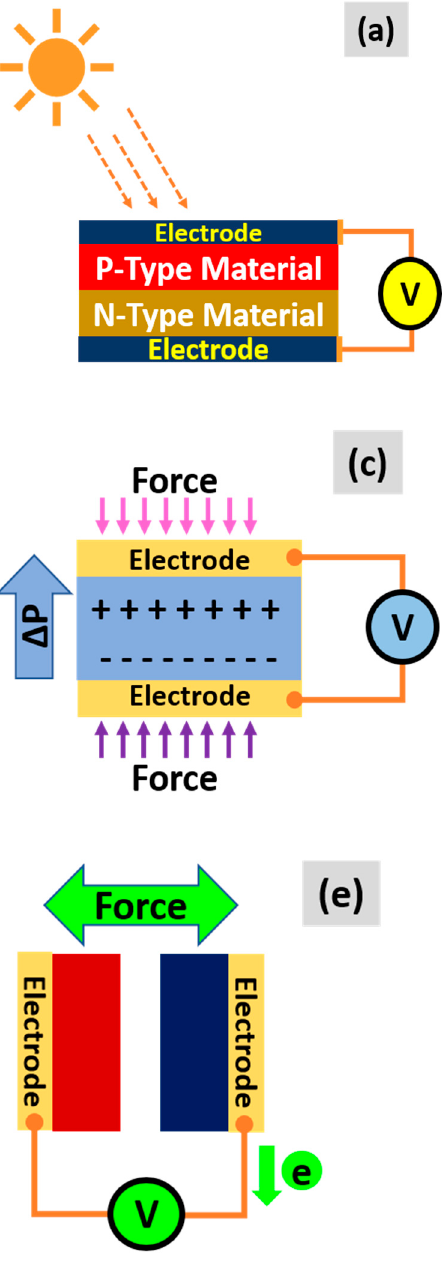
Figure 6. A schematic diagram representing various EH systems, where ( a ) photovoltaic EH, ( b ) thermoelectric EH, ( c ) piezoelectric EH, ( d ) pyroelectric EH, ( e ) triboelectric EH, and ( f ) electromagnetic induction EH.